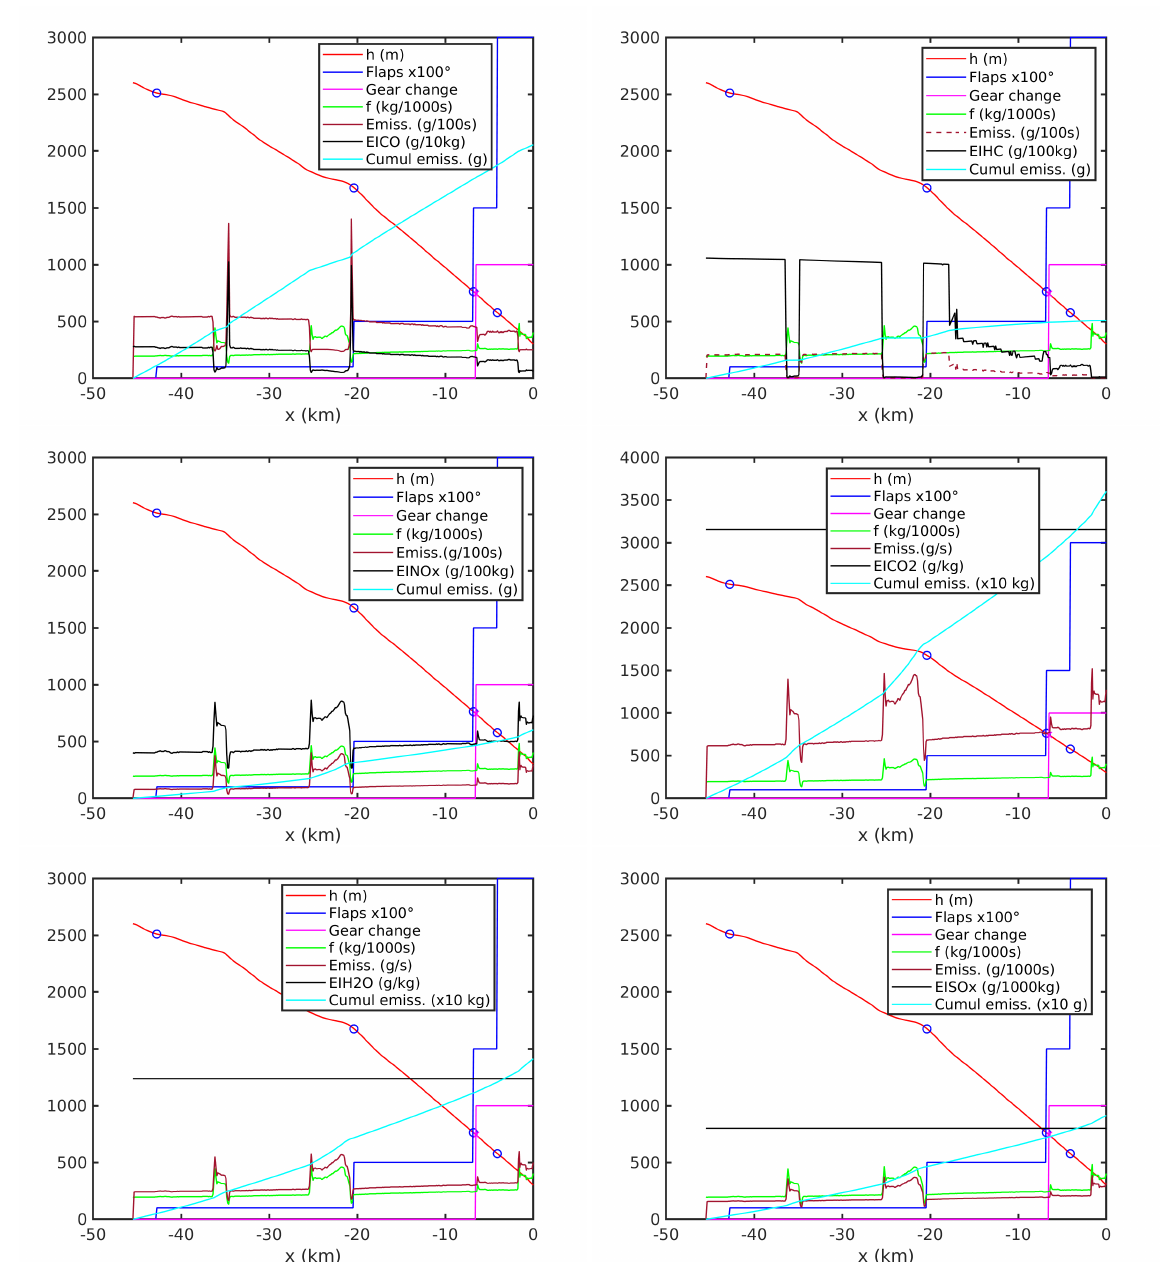
Figure 6. Emissions evolution along a flight trajectory (FDR1) for CO, HC, NO x , CO 2 , H 2 O, and SO x from top to bottom and left to right with respect to distance to final